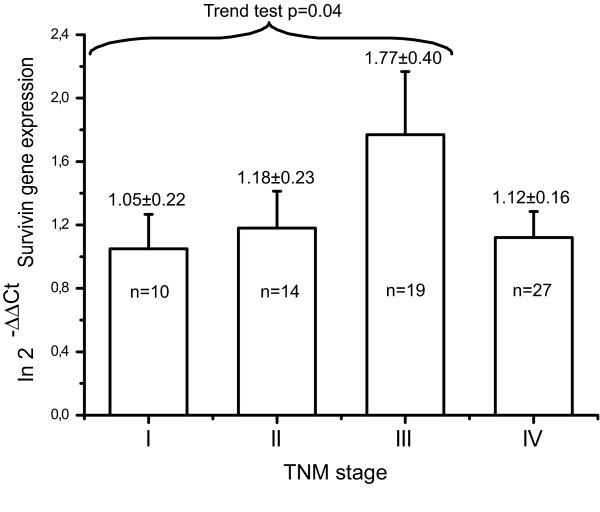
Survivin gene levels measured in the peripheral blood of 70 patients with TNM stage I to IV gastric cancer. The trend test analysis shows a significant increase in Survivin transcriptional levels across patients with stage I to III gastric cancer (trend test P-value = 0.04). For each column is reported the mean ± SD.